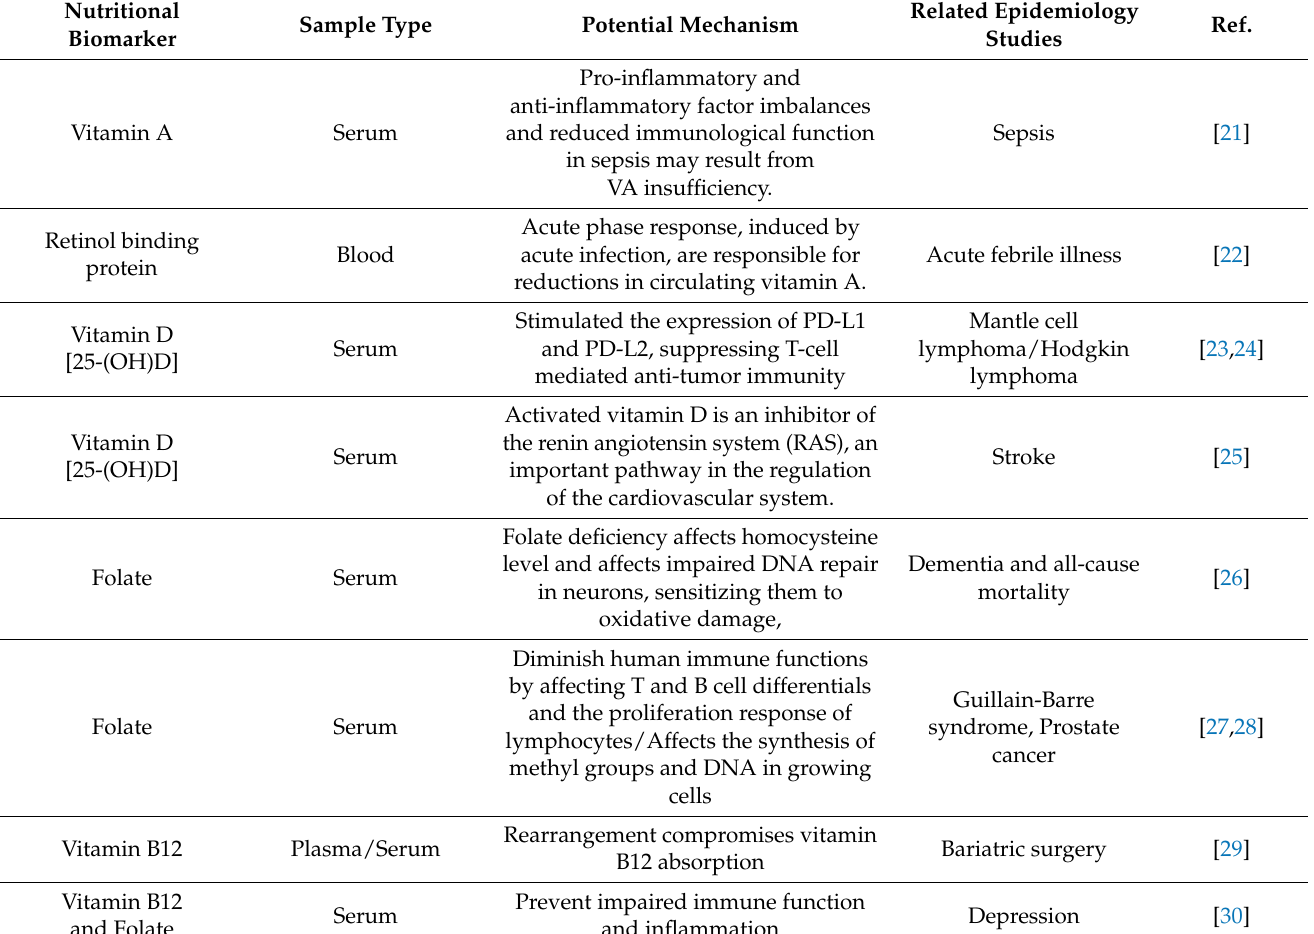
Table 1. An overview of nutritional biomarkers and related epidemiology